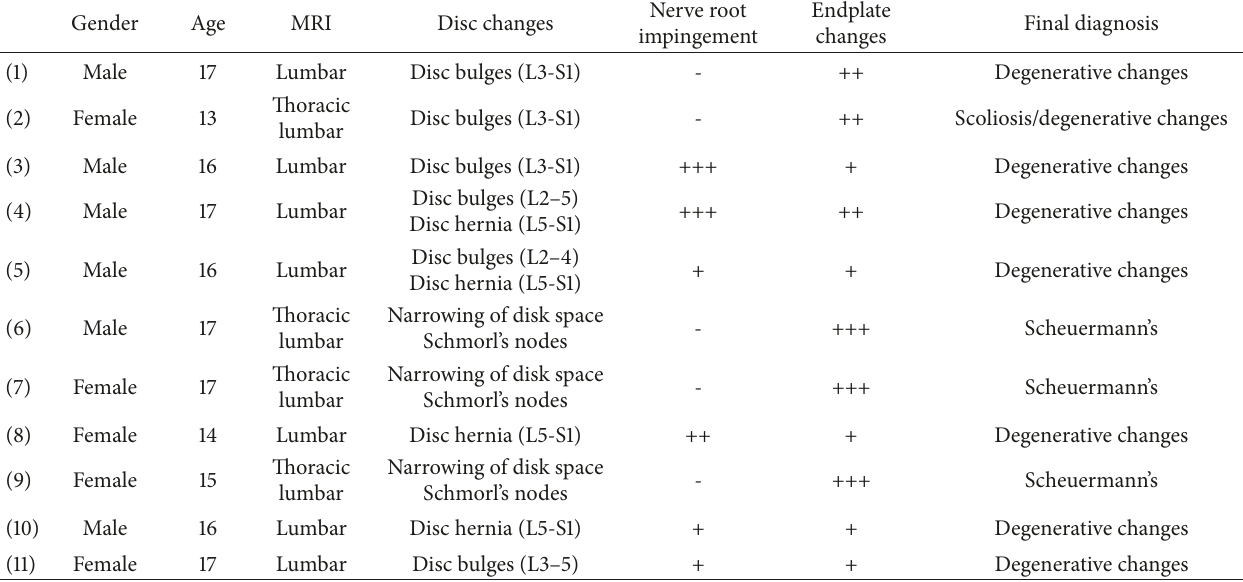
Table 1: Age, gender, MRI findings,